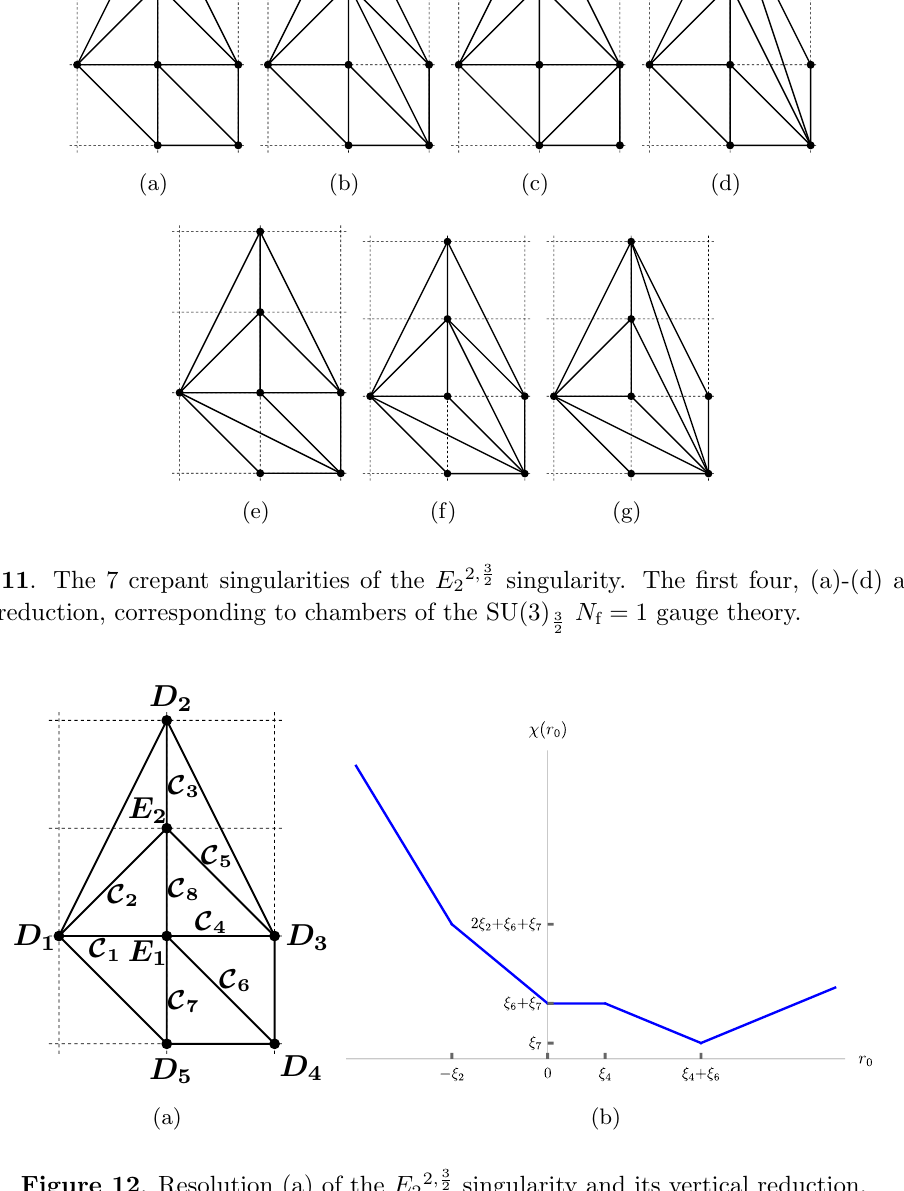
Figure 12 . Resolution (a) of the E 22 ; 3 2 singularity and its vertical